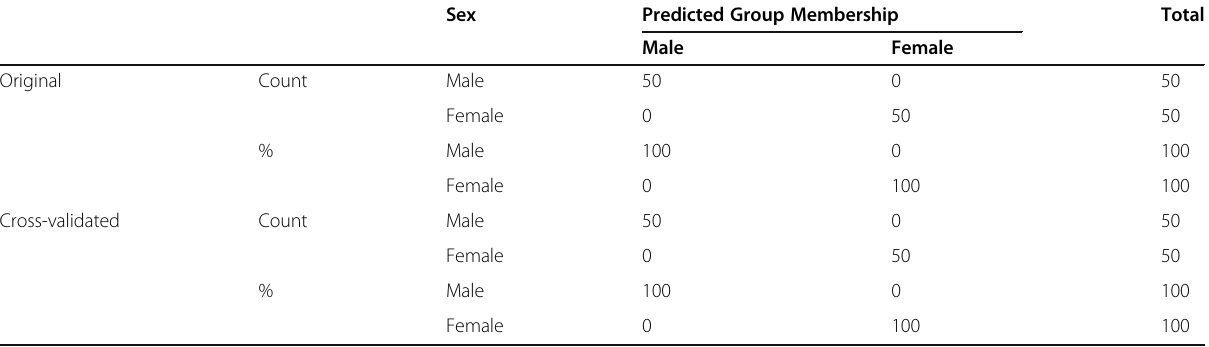
Table 8 Classification results with stepwise analysis